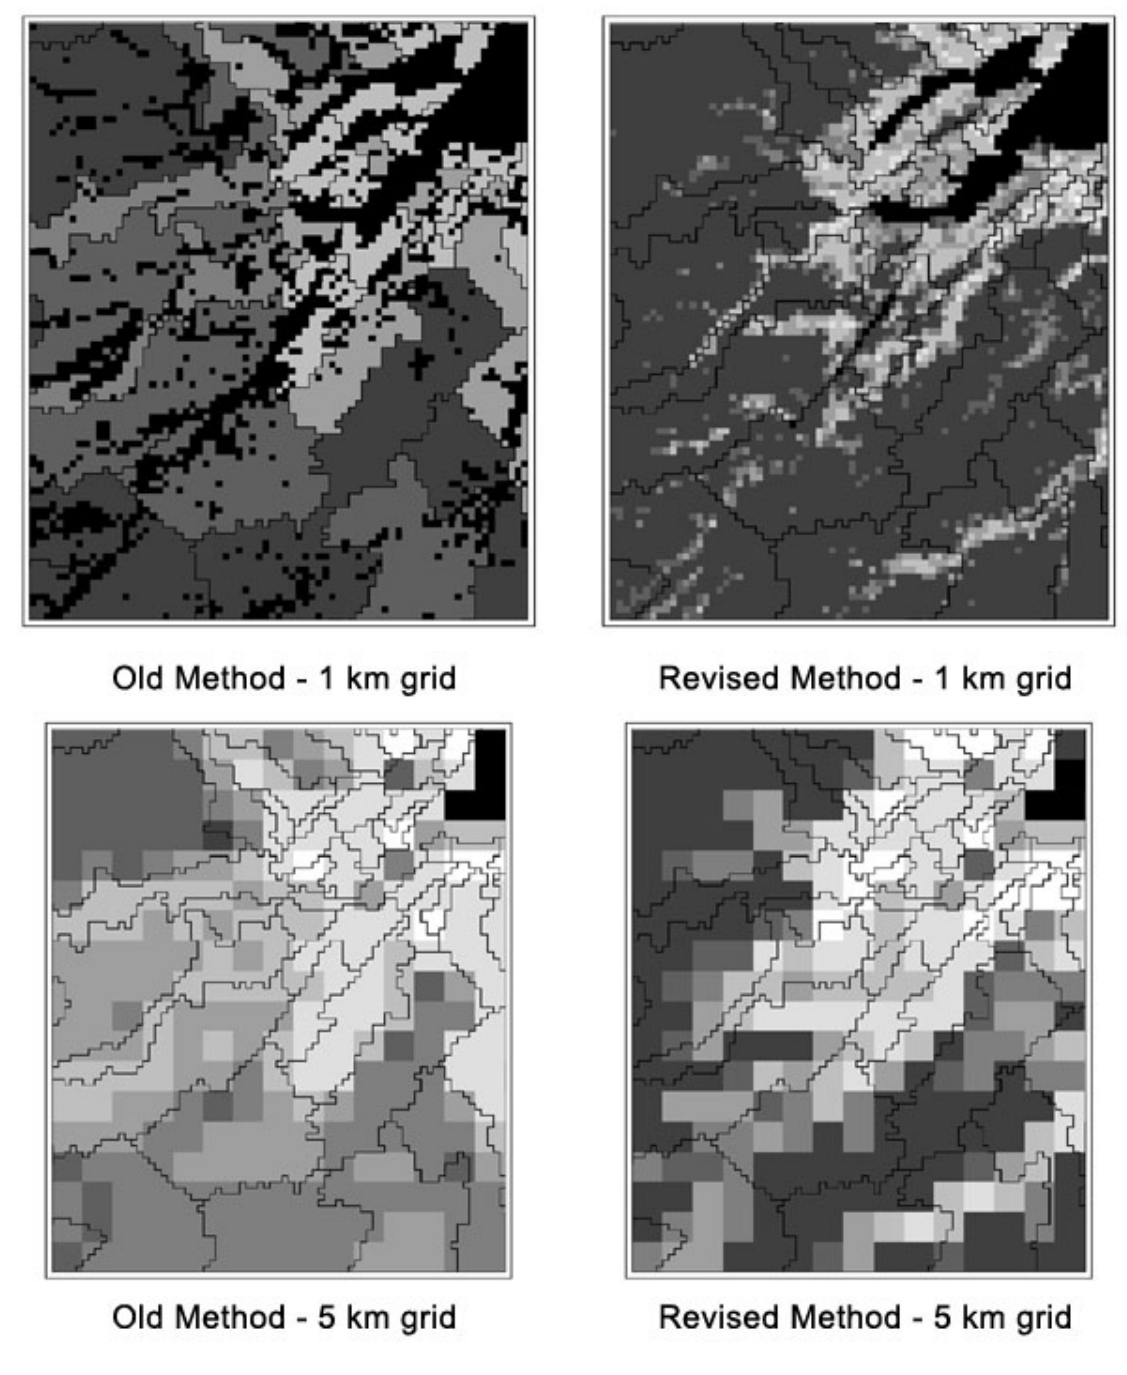
FIGURE 4. Comparison of old and new model approaches for distributing ammonia emissions at 1- and 5-km grid resolution. The maps show ammonia emissions from beef cattle around the Black Isle (Lat. 57.6; Long. –4.3), Great Glen (Lat. 57.4, Long. –4.2 to Lat. 57.1, Long. –4.7), Upper Speyside (Lat. 57.3; Long. –3.6), and surrounding areas for 1988. White indicates a high ammonia emission and black a low ammonia emission. The irregular boundaries show parishes mapped on a 1-km grid. For details of the methodology see text.